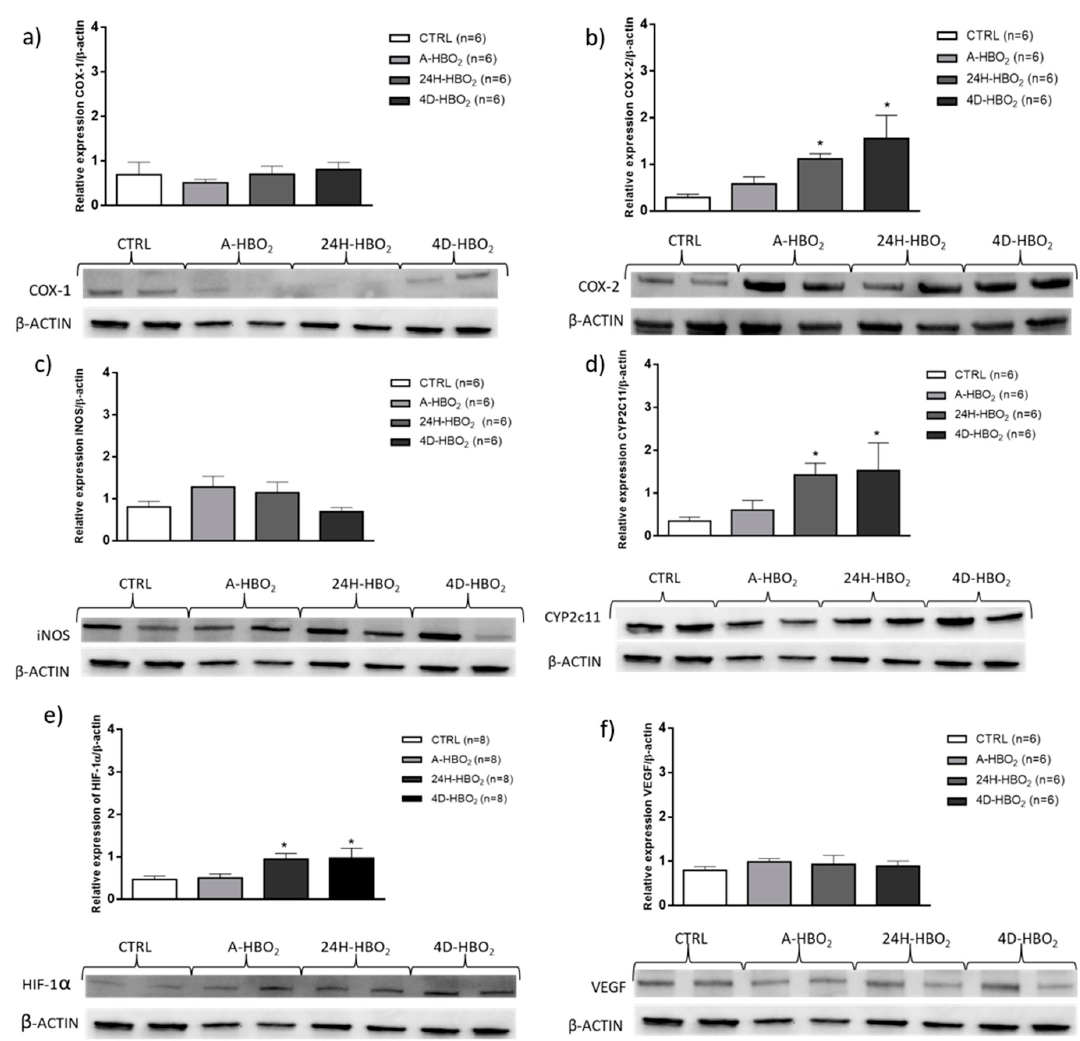
Figure 5. Relative protein expression and representative blots of ( a ) COX-1—cyclooxygenase 1; ( b ) COX-2—cyclooxygenase 2; ( c ) iNOS—inducible nitric oxide synthase; ( d ) CYP2C11; ( e ) HIF-1 α and ( f ) VEGF in aortic tissue, determined by Western blot method. Results are shown as mean ± standard deviation (SD); * p < 0.05 compared to CTRL.